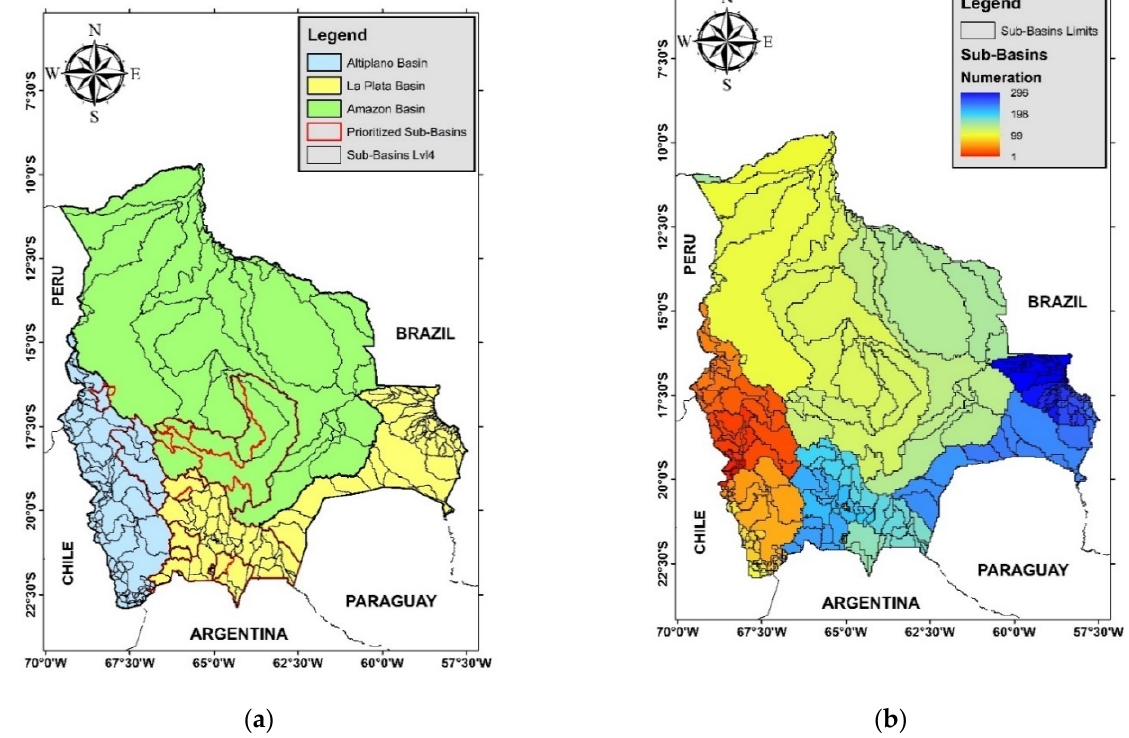
Figure 3. ( a ) Sub-basins using the Pfafstetter coding system (Level Four) and prioritized basins; ( b ) rasterized sub-basin map.